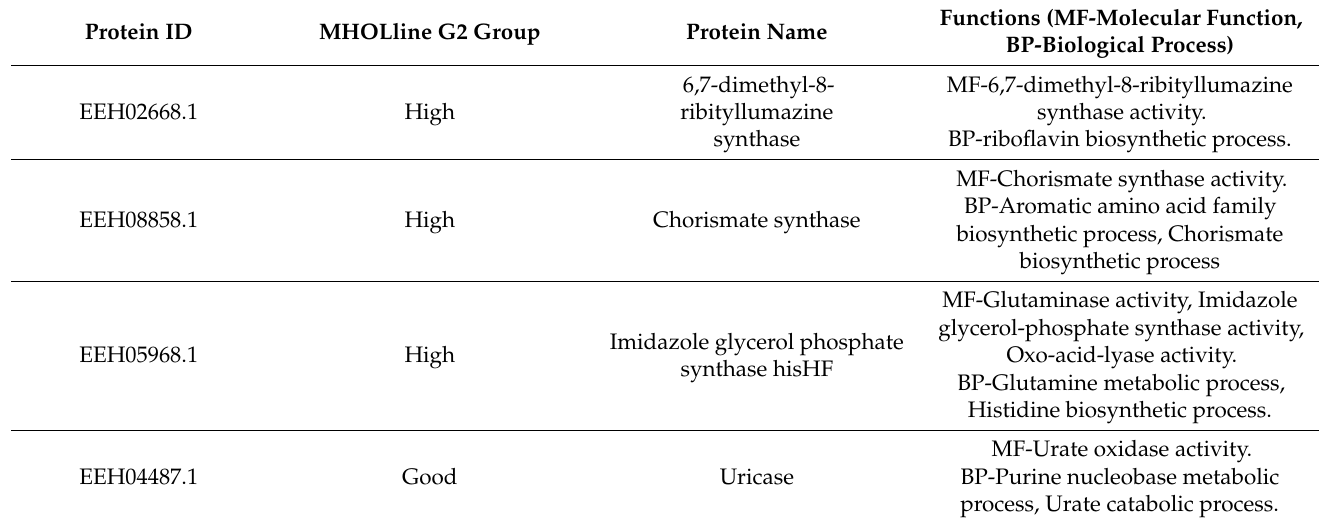
Table 4. Predicted drug targets for Histoplasma capsulatum . Protein ID and name were obtained from NCBI Genbank